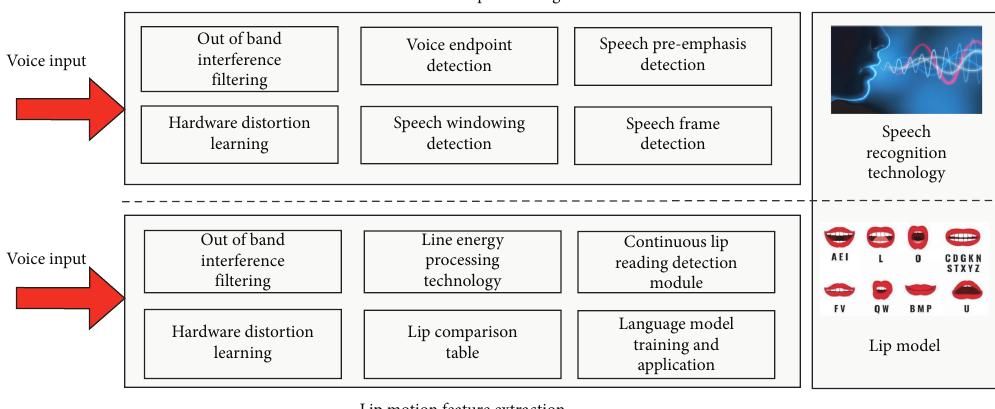
Figure 3: Schematic diagram of feature extraction of the speech recognition and lip recognition algorithm.